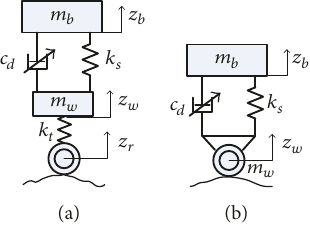
Figure 2: The single-wheel suspension